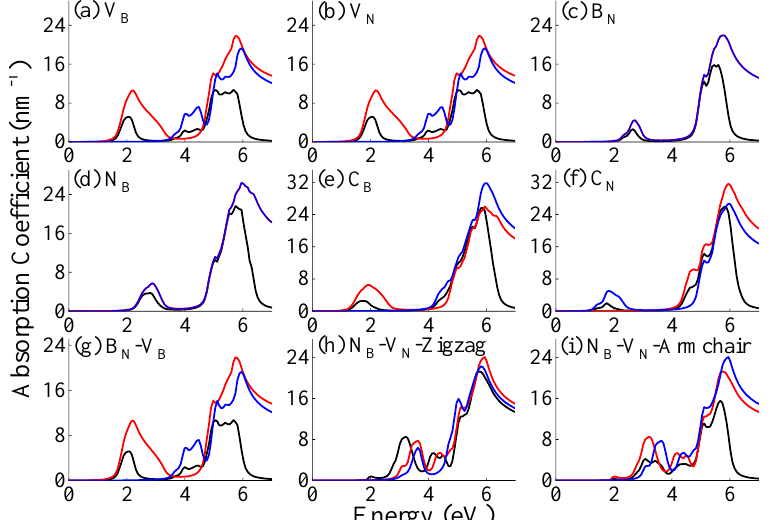
Figure 4. Spin-resolved and -unresolved absorption spectra for the hBN supercell with various defects of ( a ) V B , ( b ) V N , ( c ) B N , ( d ) N B , ( e ) C B , ( f ) C N , ( g ) B N -V B , and ( h ) N B -V N in a zigzag direction, and ( i ) N B -V N in an armchair direction. The black, red, and blue lines indicate the spin-unresolved, -up, and -down absorption spectra.